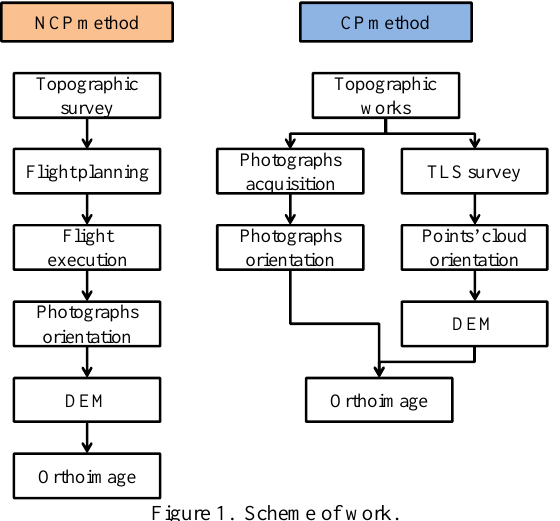
Figure 1. Scheme of work.